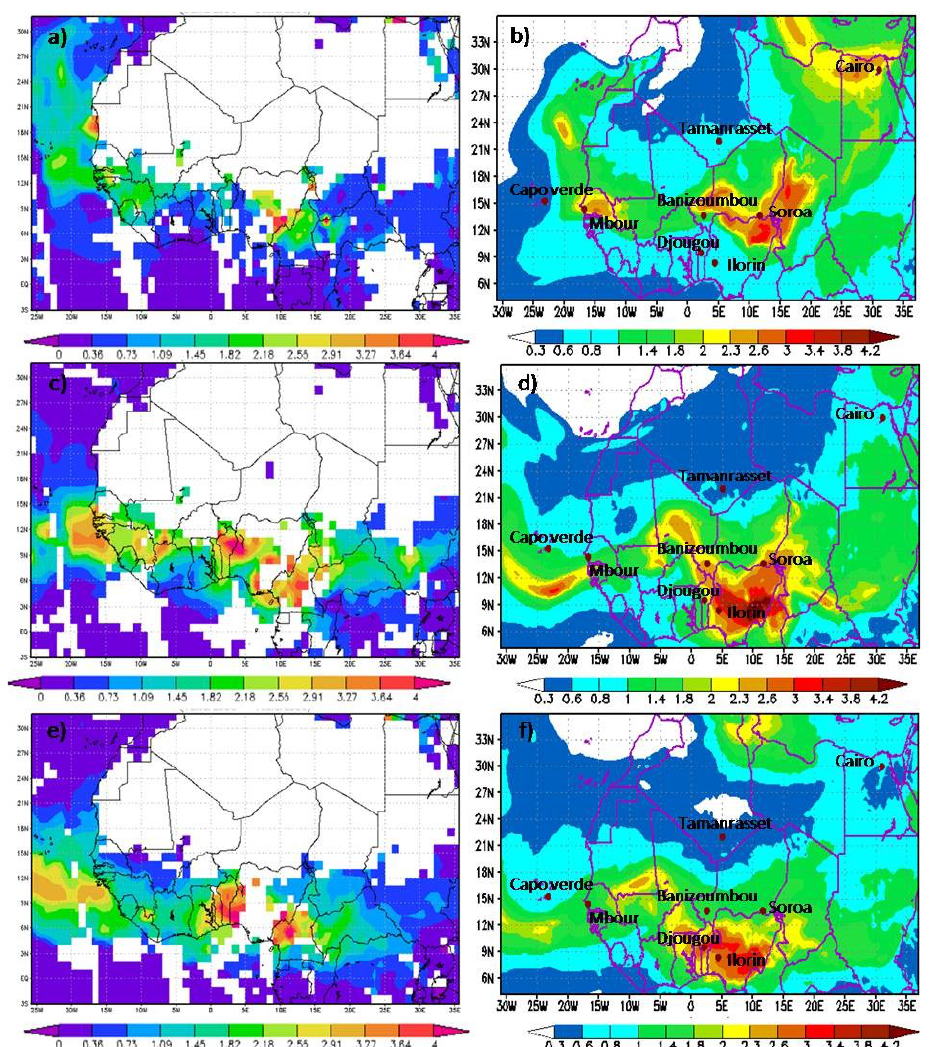
Fig. 12. Daily mean AOD (at 550nm) from MODIS/AQUA satellite images ( a, c and e ) and simulated by ALADIN ( b, d and f ) for 8 March (top), 10 (middle) and 12 (bottom), 2006.